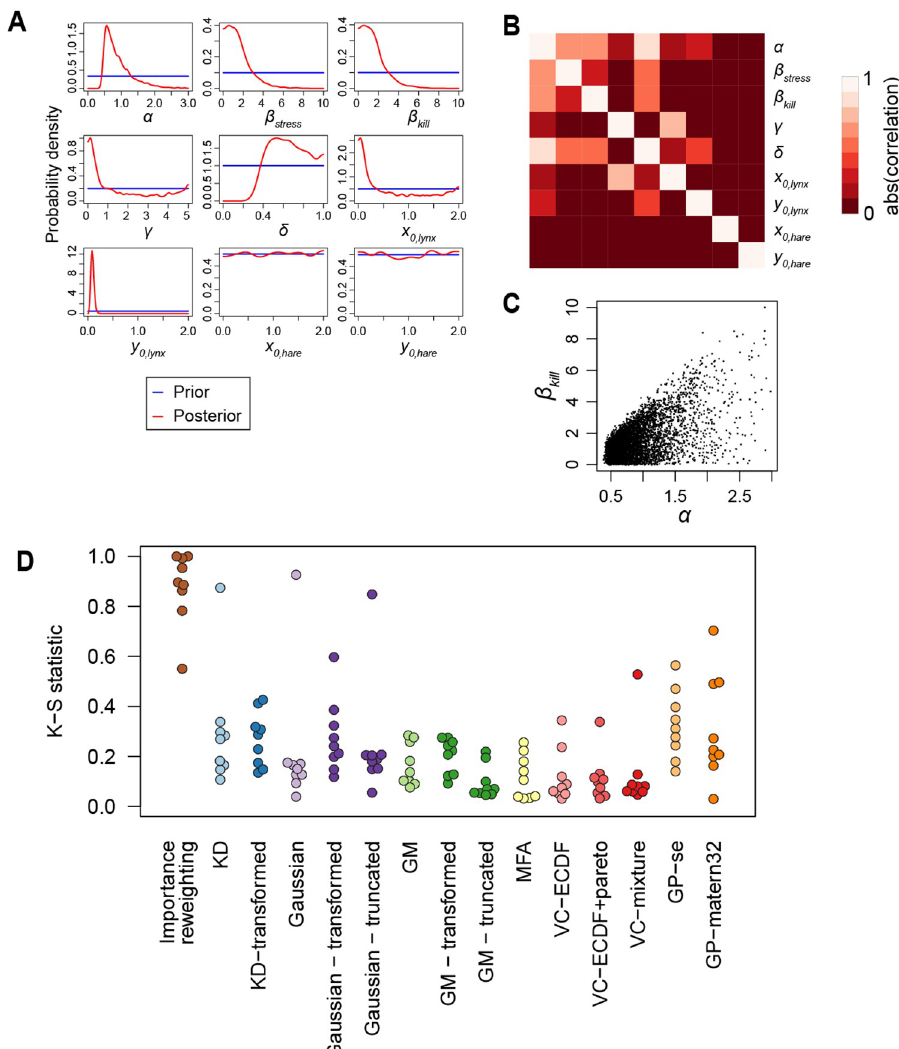
Fig 7. Sequential inference with bounded priors. (A) Marginal posterior densities after seeing the lynx data; compare with Fig 5A. (B) Correlations between the parameters in the lynx posterior. (C) Scatter plot of the samples for one parameter combination. (D) Sequential inference accuracy; same as in Fig 6, with the addition of transformed and truncated variations.